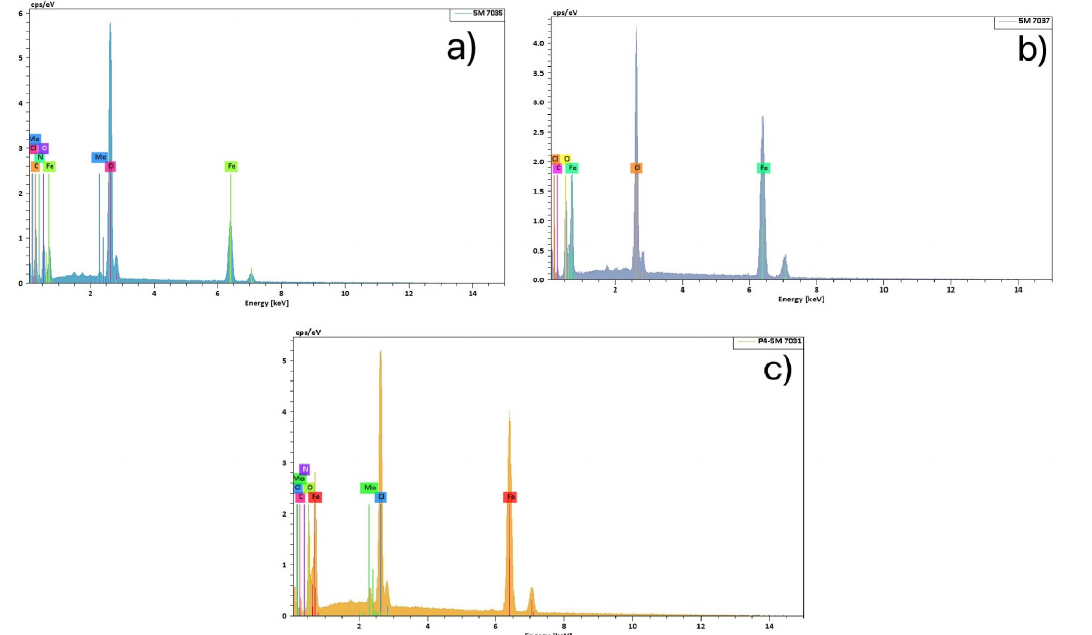
Figure 12. EDX spectra for ordinary mild steel surface after 24 h of immersion in 5.0 M HCl solution (a) blank solution, (b) with the presence of 10-3 M of P3, and (c) with the presence of 10-3 M of